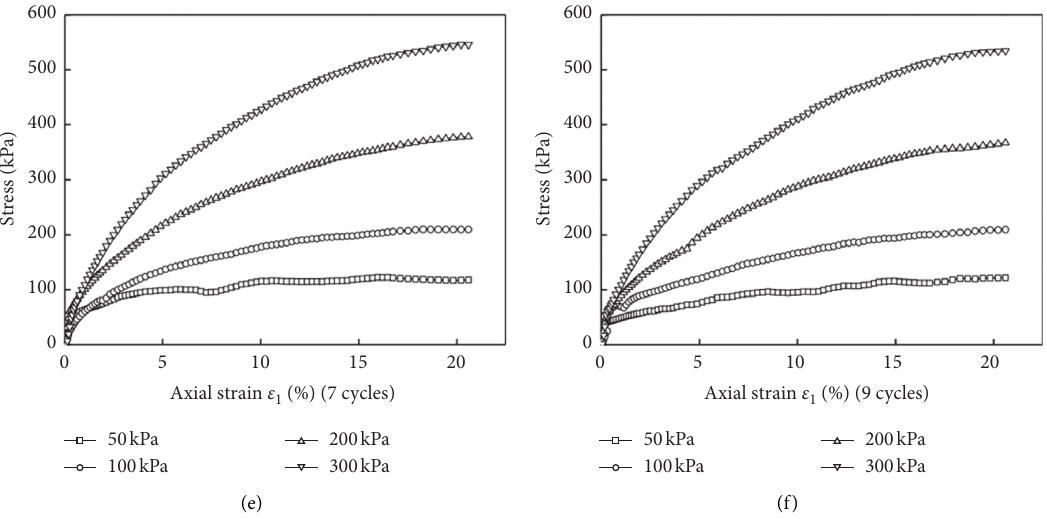
Figure 12: Deviatoric stress-axial strain relation curve of red clay under different wet and dry cycles.